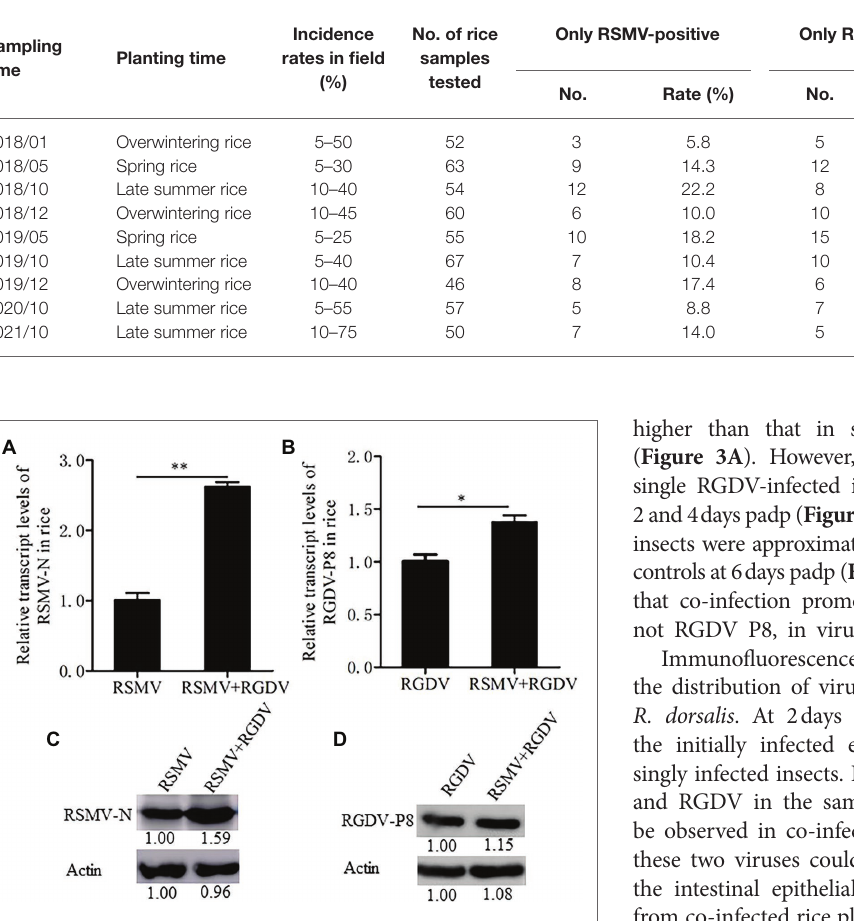
TABLE 1 | RSMV and RGDV distribution in Luoding, Guangdong province during 2018–2021.